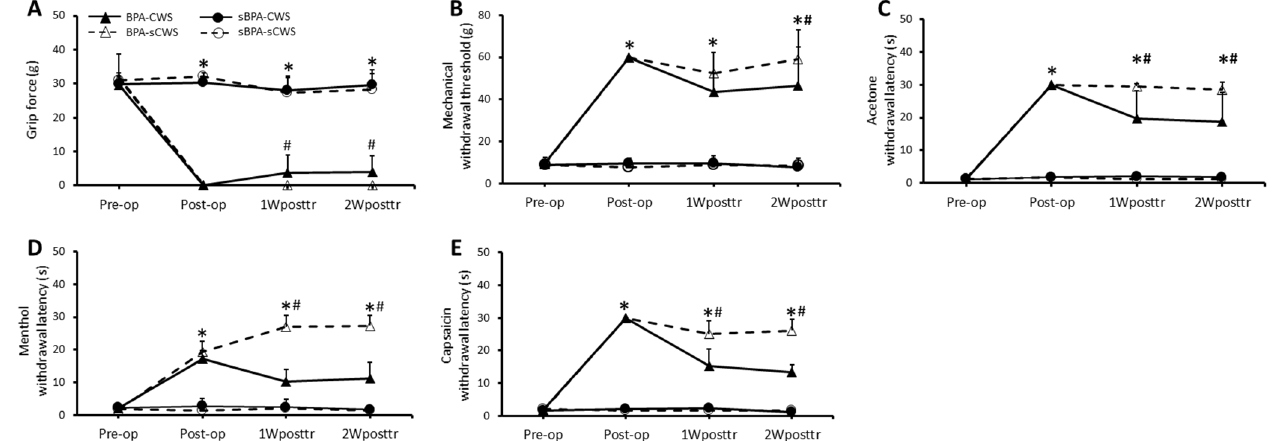
Figure 1. Effects of cold-water swimming (CWS) treatment on grip force of front limbs ( A ), mechanical withdrawal threshold ( B ), cold withdrawal latency ( C ), reaction latencies of menthol—( D ) and capsaicin—( E ) evoked nocifensive behavior in the four groups. There were no significant differences among the four groups before surgery; * p < 0.05 indicates significant differences among the four groups analyzed using Kruskal–Wallis test. # p < 0.05 indicates significant difference between BPA–CWS and BPA–sCWS groups analyzed using Mann–Whitney test.